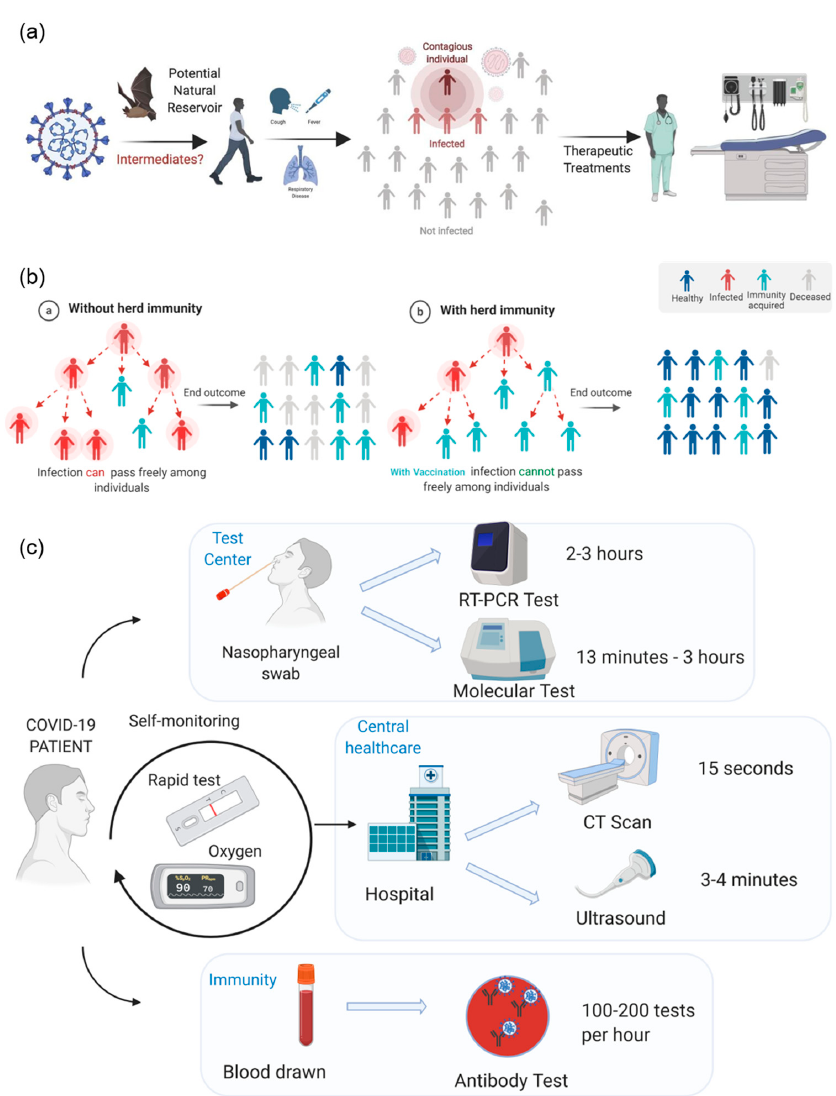
Figure 1. COVID-19 origins, transmission, immunity, and diagnostics. ( a ) Animals such as bats are a potential natural reservoir, and other intermediates facilitate the infection of coronavirus to humans. Human-to-human transmission is a common characteristic in three types of coronaviruses, severe acute respiratory syndrome coronavirus (SARS-CoV), SARS-CoV-2, and Middle East respiratory syndrome coronavirus (MERS-CoV). Even though the fatality rate is not lower than SARS-CoV and MERS-CoV, vaccines and treatments are needed; ( b ) Herd immunity plays an essential role in controlling the transmission of the disease. Without herd immunity, the virus will be available to get transferred from infected patients to any susceptible individual, resulting in a high infection rate and high mortality. On the other hand, herd immunity interrupts this chain of infection, resulting in better outcomes with less infected individuals and a significantly reduced the mortality rate; ( c ) The three main categories of COVID-19 diagnostics and the time-frame of each: laboratory test centers for current infection, medical screenings, antibody tests to determine immunity. Test centers use samples from nasopharyngeal swabs and test for COVID-19 infection via molecular or reverse transcription-polymerase chain reaction (RT-PCR) tests, with RT-PCR tests taking longer. Healthcare clinics and hospitals o ff er quick medical screenings via computed tomography (CT) scans or ultrasounds; ultrasounds are the safer option due to no radiation. The next step in rapid testing will be to test COVID-19 patients for antibodies against SARS-CoV-2 to see if the patient has the potential to fight reinfection and determine if the individual was previously